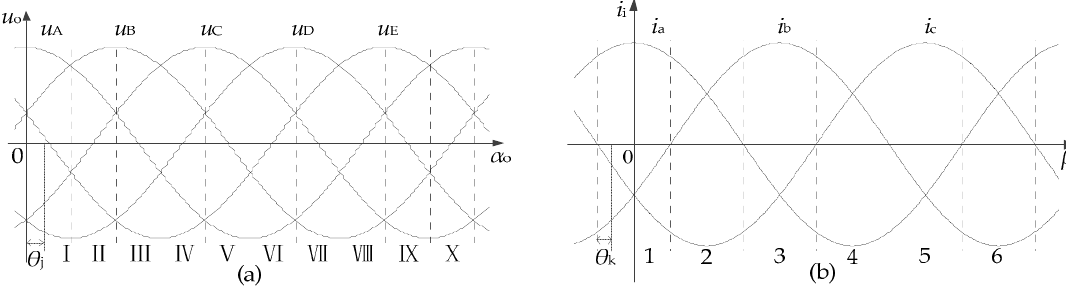
Figure 4. Segment partition ( a ) output voltages and ( b ) input currents.